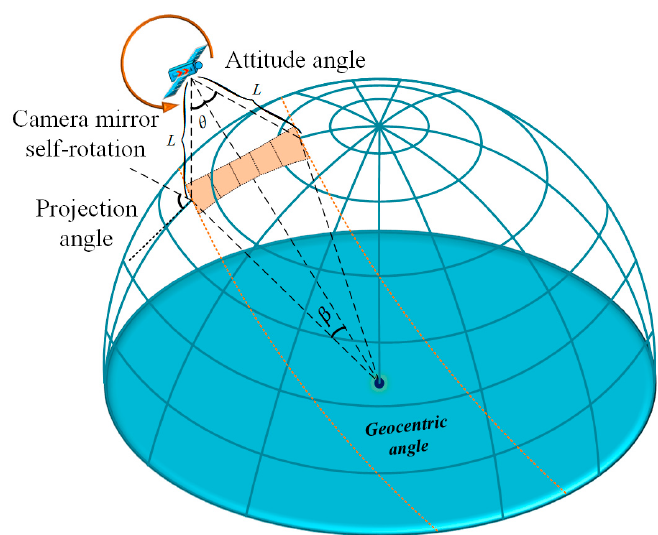
Figure 3. Schematic diagram of overall dynamic frame by frame imaging.